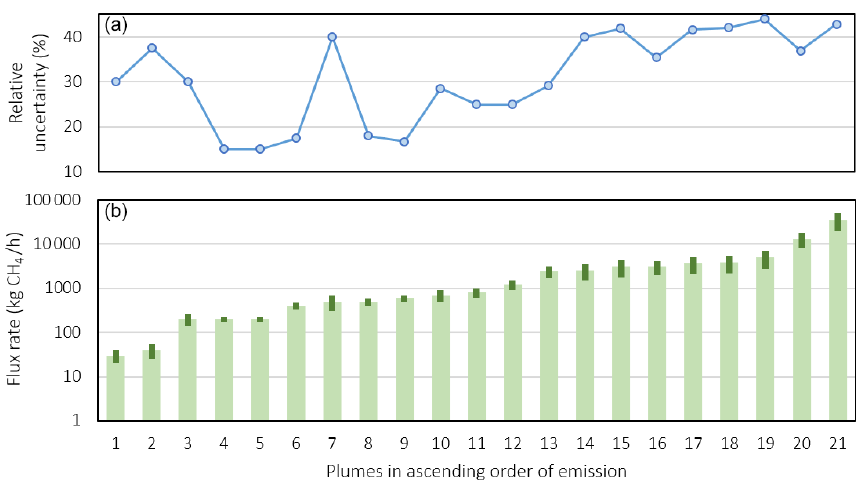
Figure 10. Distribution of emission rates in ascending order for the 21 estimated Q flux rates listed in Table 1, which correspond to the 26 single methane plumes detected with WV-3. The bars in panel (b) for each Q (the axis is in logarithmic scale) enclosed, at its upper end, the corresponding ± σ value displayed by thinner and darker bars. Panel (a) shows the relative uncertainty in % for each associated emission of panel (b) .